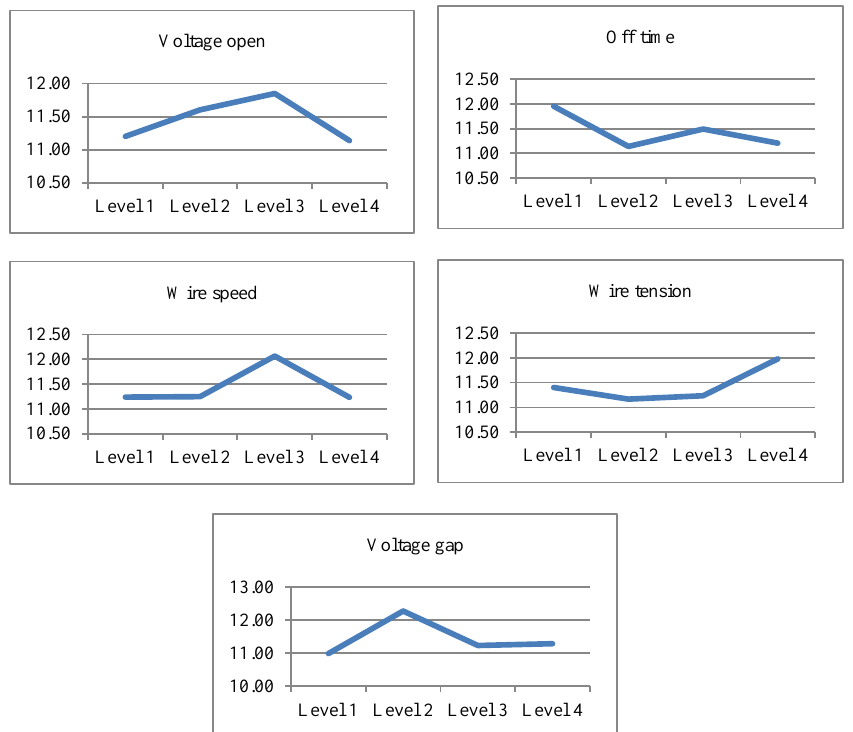
Figure 2: Effects of process parameters on mean S/N ratio for